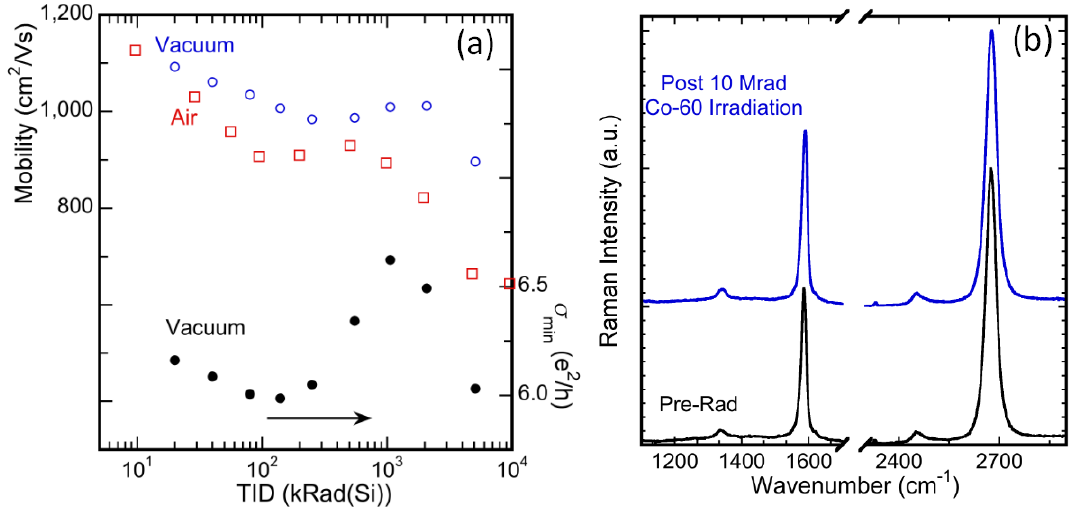
Figure 3. ( a ) Field effect mobility as a function of TID for a graphene-FET irradiated in vacuum (blue, open circles) and in air (red, open squares), along with the minimum conductivity ( i.e. , the conductivity at the Dirac point) for the transfer characteristics measured in vacuum; ( b ) Representative Raman spectra of the graphene FET both pre- and post 10 Mrad(Si)